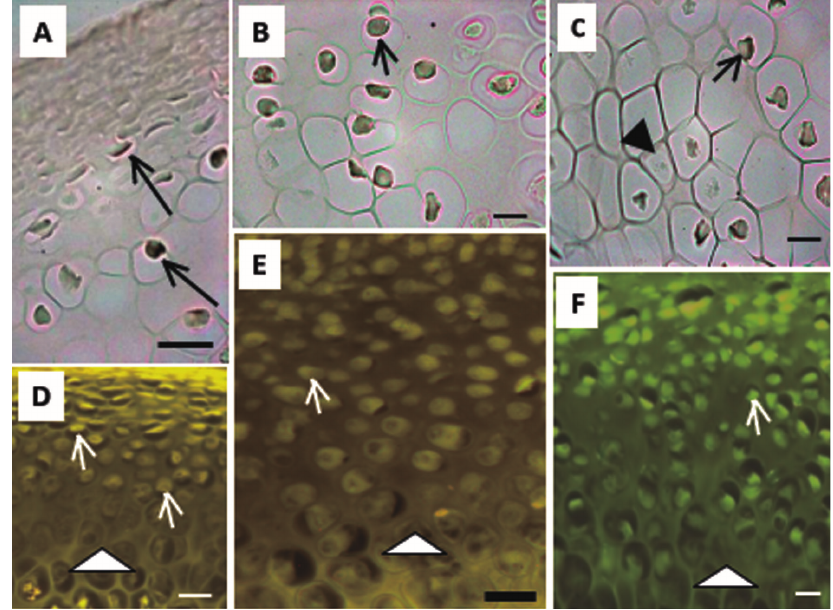
Figure 6- Insulin Receptors (IR) of the mandible condylar process cartilage (CP) of Wistar rats. A - C: IR immunohistochemistry; D - F: IR immunofluorescence. The arrows show the sensitized cells to IR (immunostained) and arrowheads point to cells not